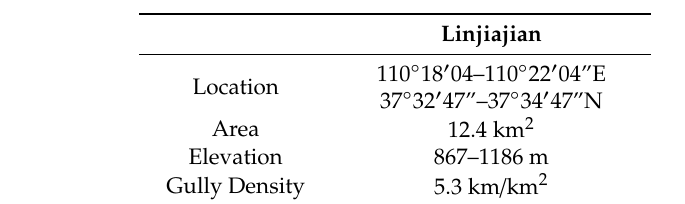
Table 2. Geography of Study Areas.